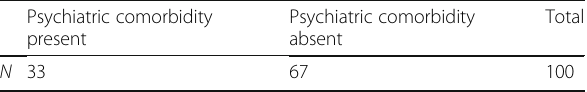
Table 3 Distribution among study population based on the presence or absence of psychiatric